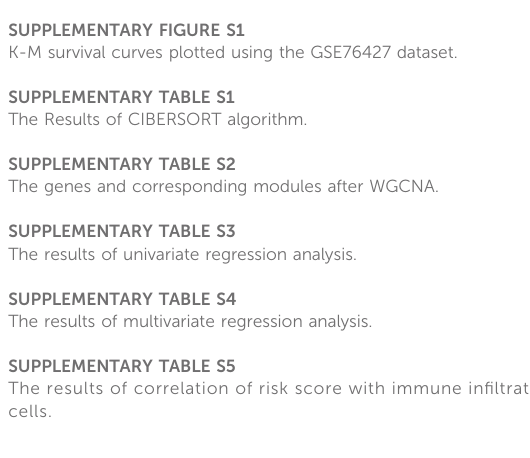
SUPPLEMENTARY FIGURE S1 K-M survival curves plotted using the GSE76427 dataset. SUPPLEMENTARY TABLE S1 The Results of CIBERSORT algorithm. SUPPLEMENTARY TABLE S2 The genes and corresponding modules after WGCNA. SUPPLEMENTARY TABLE S3 The results of univariate regression analysis. SUPPLEMENTARY TABLE S4 The results of multivariate regression analysis. SUPPLEMENTARY TABLE S5 The results of correlation of risk score with immune in fi ltrating